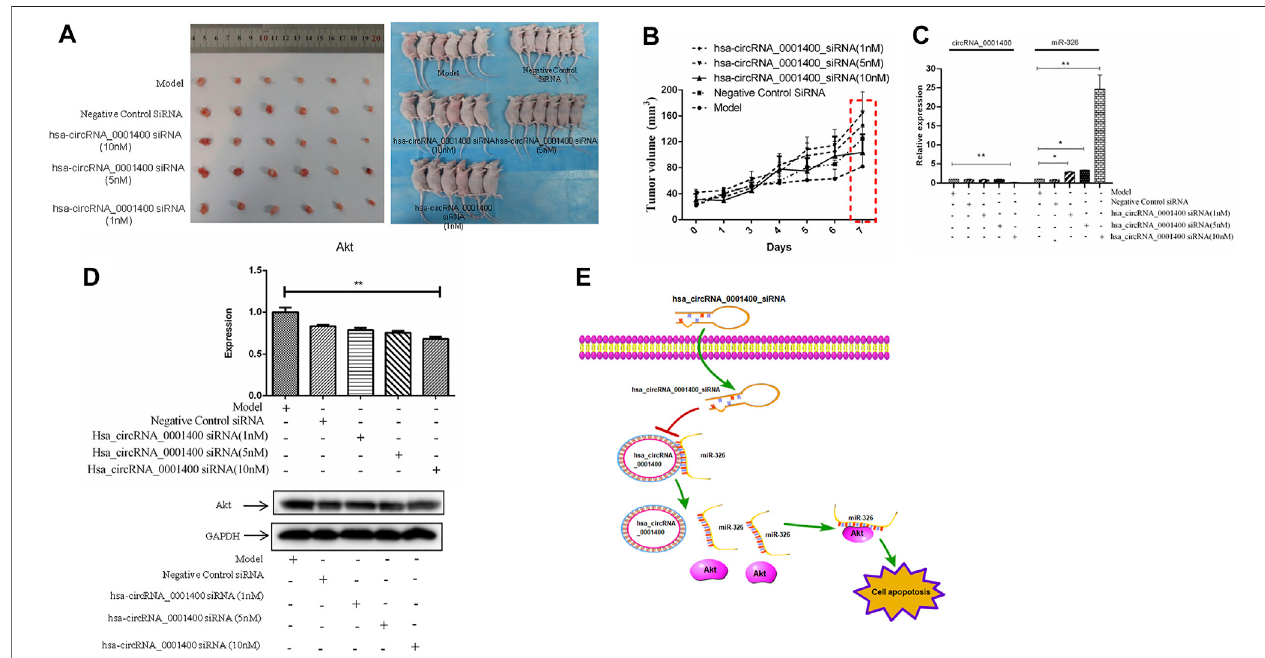
FIGURE5| Hsa-circRNA_0001400_siRNAinhibitsthegrowthofcervicalxenografttumors. (A) Tumorvolume; (B) tumorgrowthcurve; (C) theexpressionlevelsof hsa-circRNA_0001400 and miR-326; (D) the expression of Akt in tumor tissue; and (E) the pattern of action. Data are expressed as mean ± standard deviation, n (cid:2) 3, * p < 0.05 and * * p < 0.01 vs. control